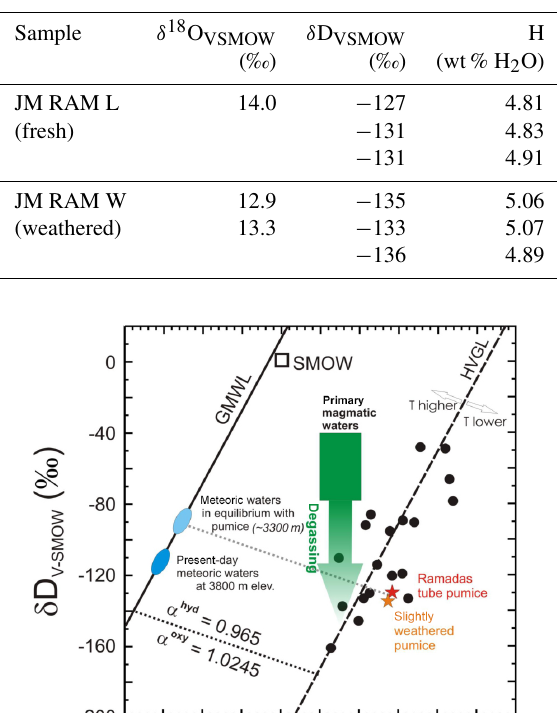
Table 3. H and O isotope information.